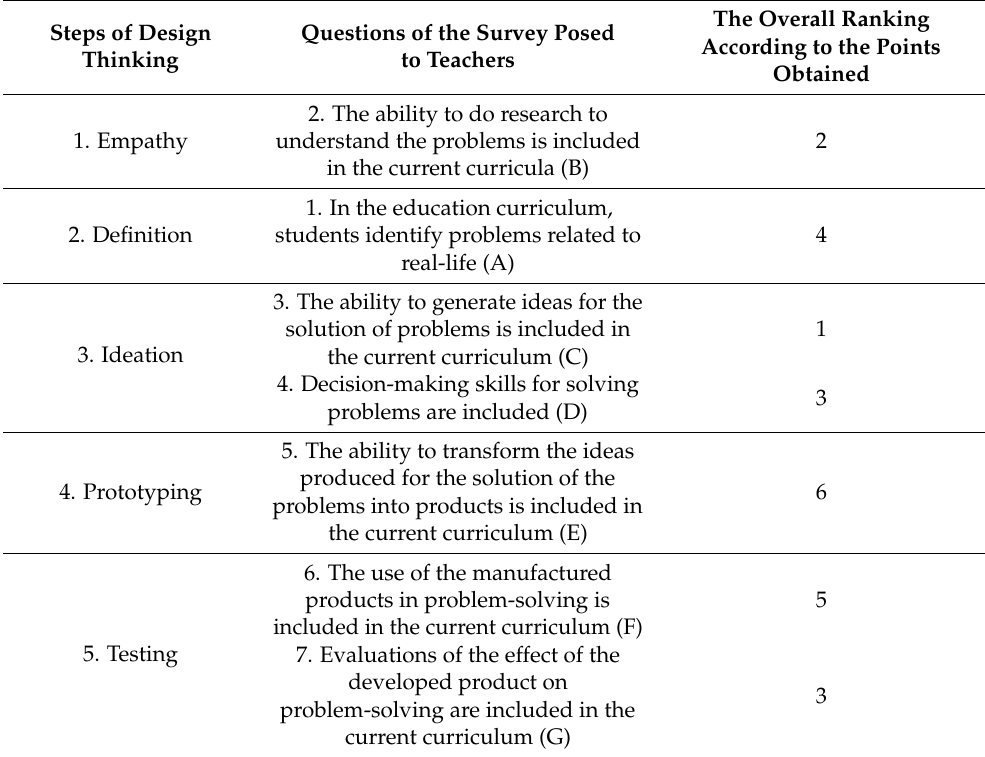
Table 1. The ranking of DT steps in the survey.